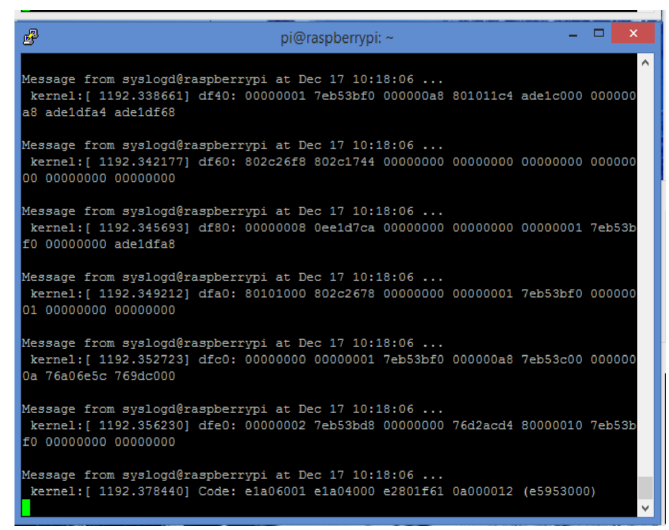
Figure 9. System crashes with more than nine nodes.